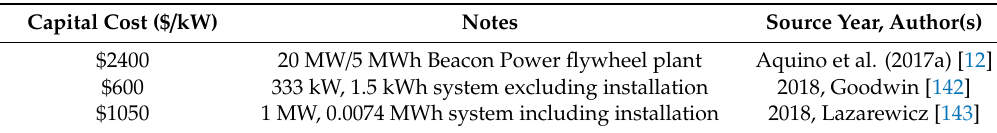
Table 28. Capital cost estimates-flywheel